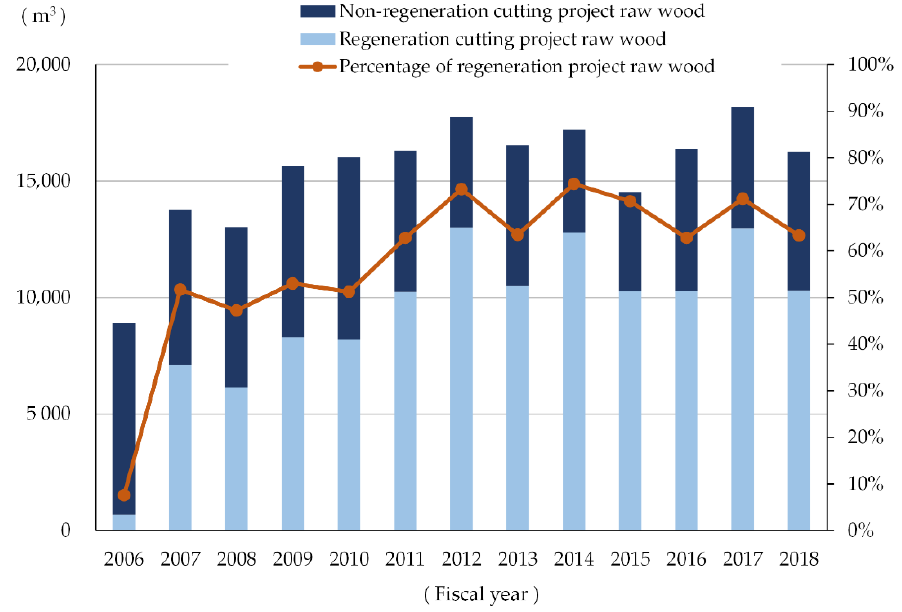
Figure 4. Handling volume of raw wood from the regeneration cutting project at Tama Roundwood Market Center.